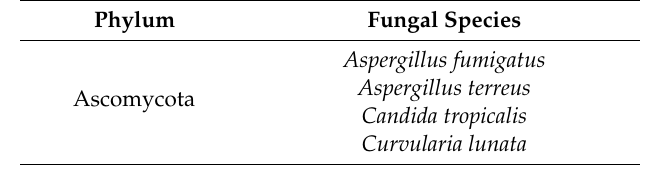
Table 1. Fungal species used in this study representing common human respiratory-associated species. Ascomycota ( n = 4) and Basidiomycota ( n = 1) were included in mock communities tested to examine for preferential PCR amplification and sequencing outcomes.